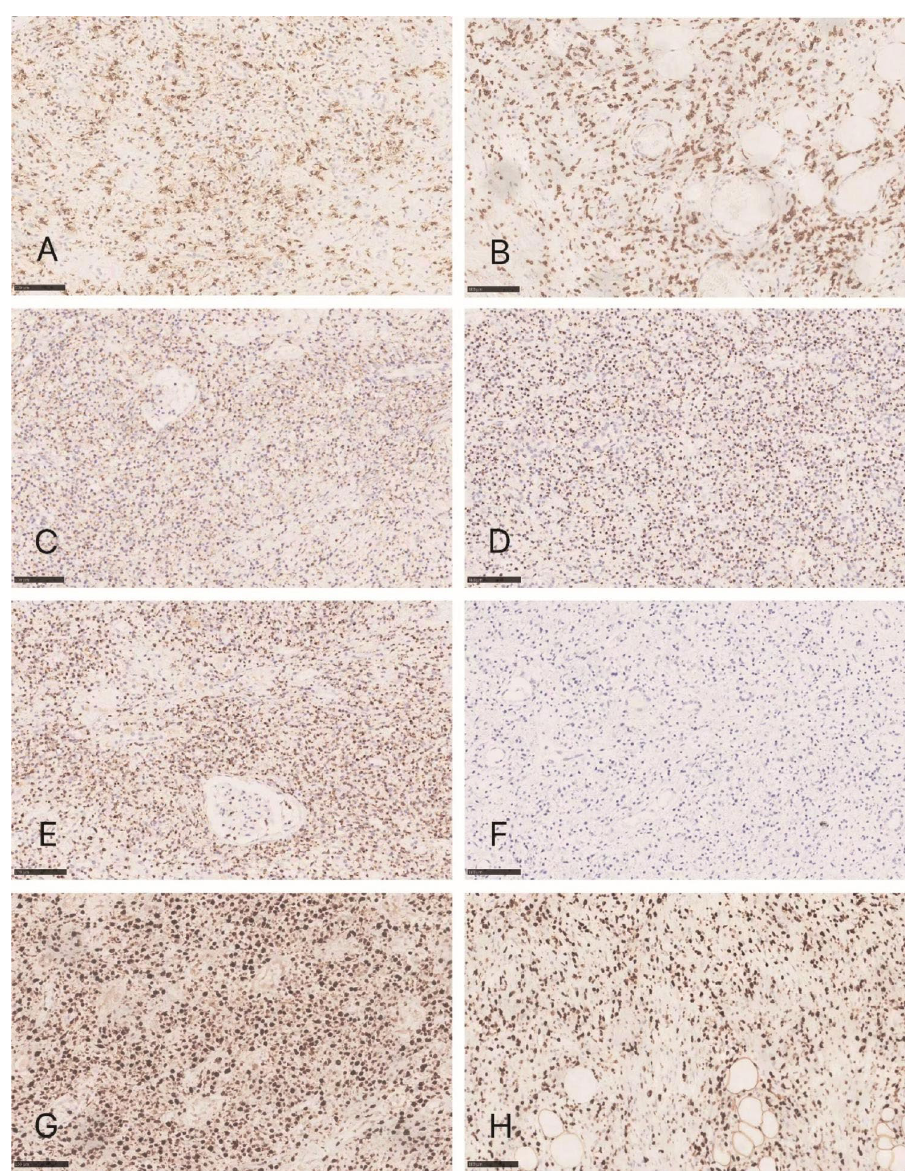
Fig. 3 Immunohistochemical analysis show that tumor cells are positive for CD3 (A) , CD56 (B) , granzyme B (C) , TIA-1 (D) , and perforin (E) and negative for CD20 (F) . The Ki-67 proliferation index reach up to 90% (Fig. 3G). In situ hybridization for EBER show strong positivity in most of the tumor cells (Fig. 3